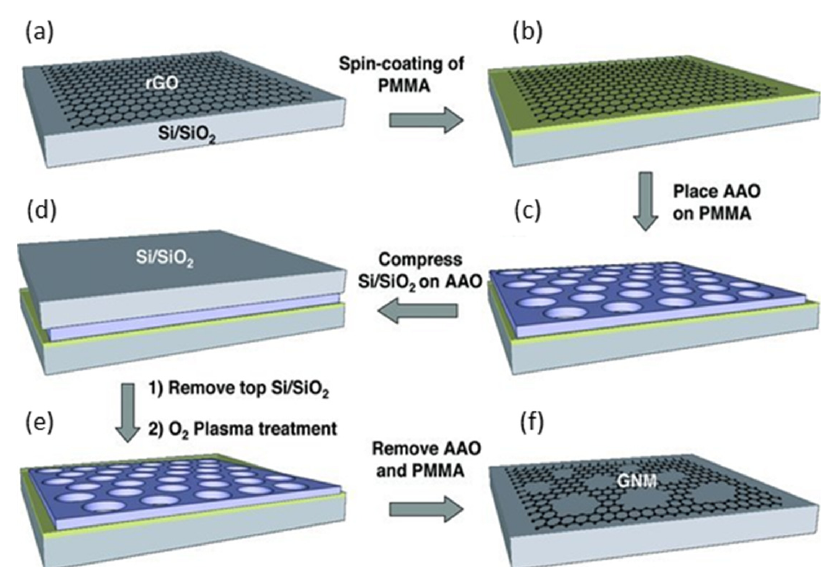
Figure 20. Schematic illustration of the route developed by Zeng et al. [201]: graphene nanoribbons are obtained using an etching mask of PAA. ( a ) Graphene transfer on a Si/SiO 2 substrate, ( b ) Spin- coating of PMMA, ( c ) Placing of PAA template on PMMA, ( d ) Compression using Si/SiO 2 substrate, ( e ) Plasma treatment to etch the graphene, ( f ) removal of the PAA and PMMA film. Reprinted with permission from Ref. [201]. Copyright © 2023 WILEY-VCH Verlag GmbH & Co. KGaA, Weinheim,